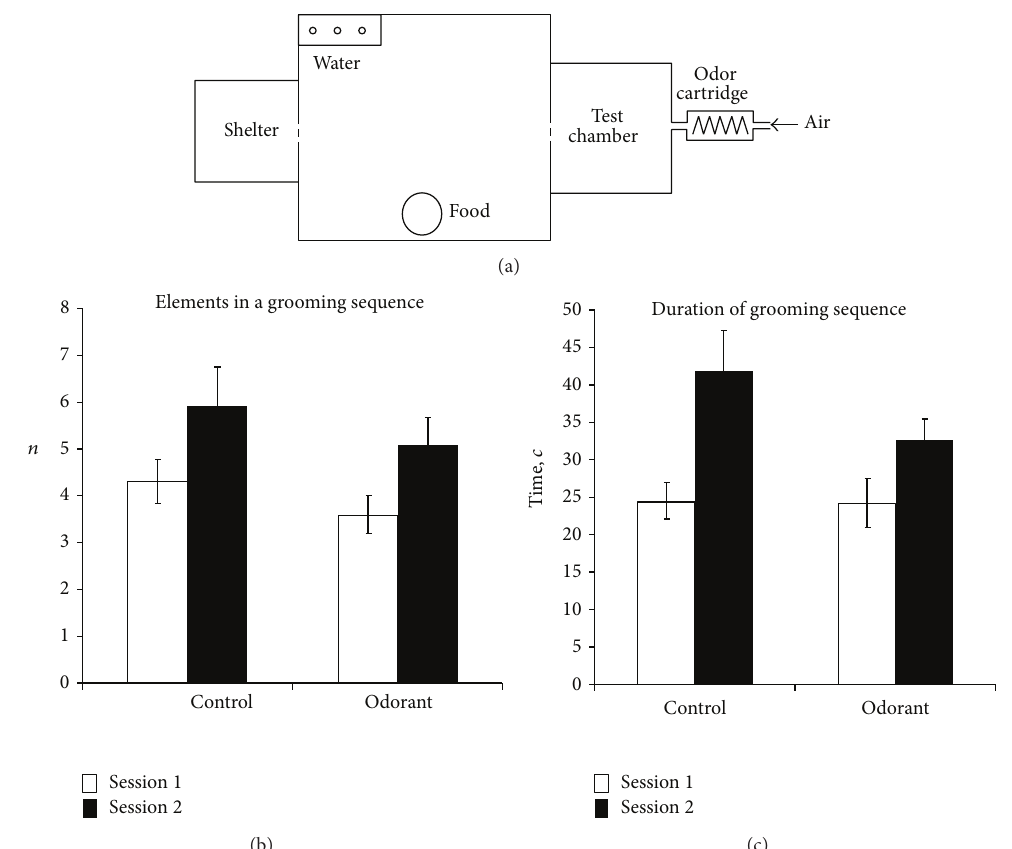
Figure 1: (a) Scheme of experimental setup. (b) The average number of events in a grooming sequence. Error bars are standard errors. (c) Average duration of grooming sequence (s). Error bars are standard errors.